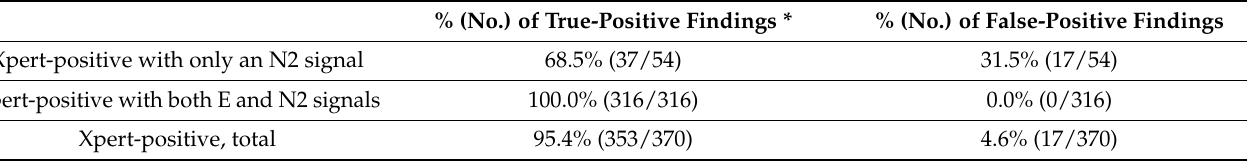
Table 2. Clinical performance of the Xpert assay in SARS-CoV-2-positive individuals.